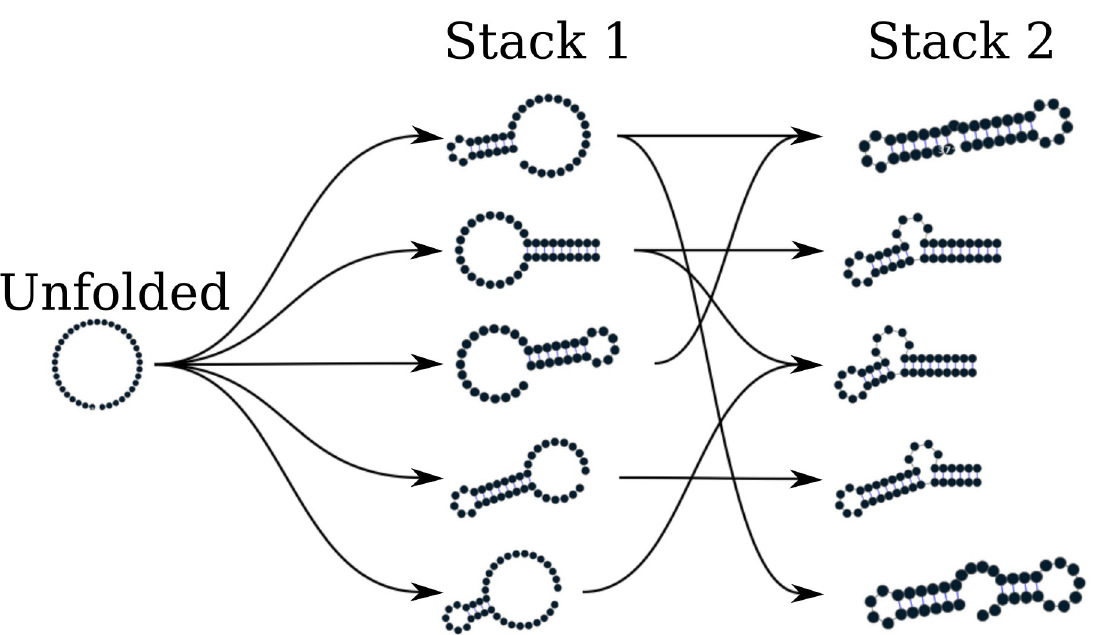
Fig 4. Execution time comparisons. For samples of 30 sequences per length, we averaged the execution times of five folding tools. The empirical time complexity O ( L η ) where η is obtained by non-linear regression. RAFFT denotes the naive algorithm whereas RAFFT(50) denotes the algorithm where 50 structures can be saved per